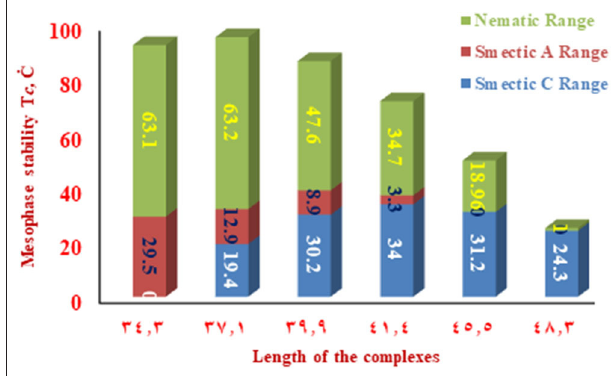
FIGURE 7 | The dependence of the smectic A, C, and nematic temperature ranges on the molecular length of the SMHBCs I/A n .